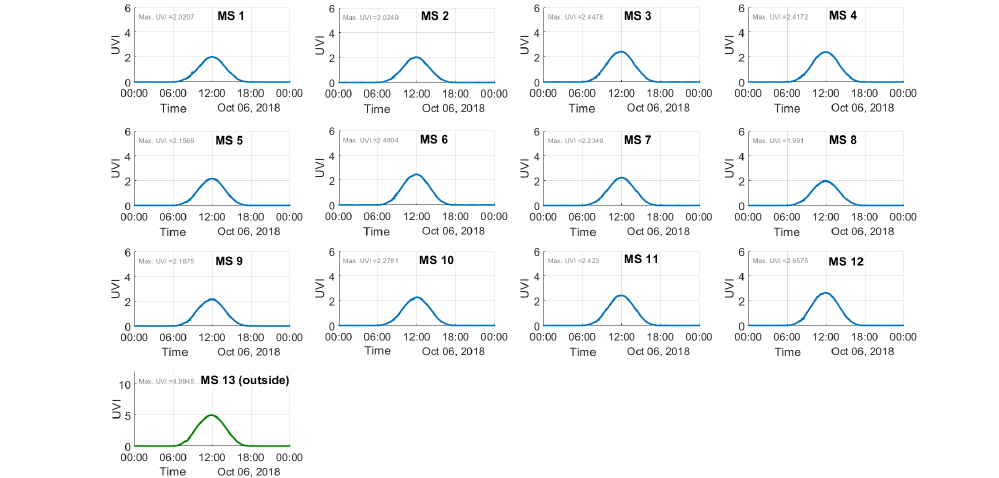
Figure 5. UVI measured by all measurement stations during 6 October